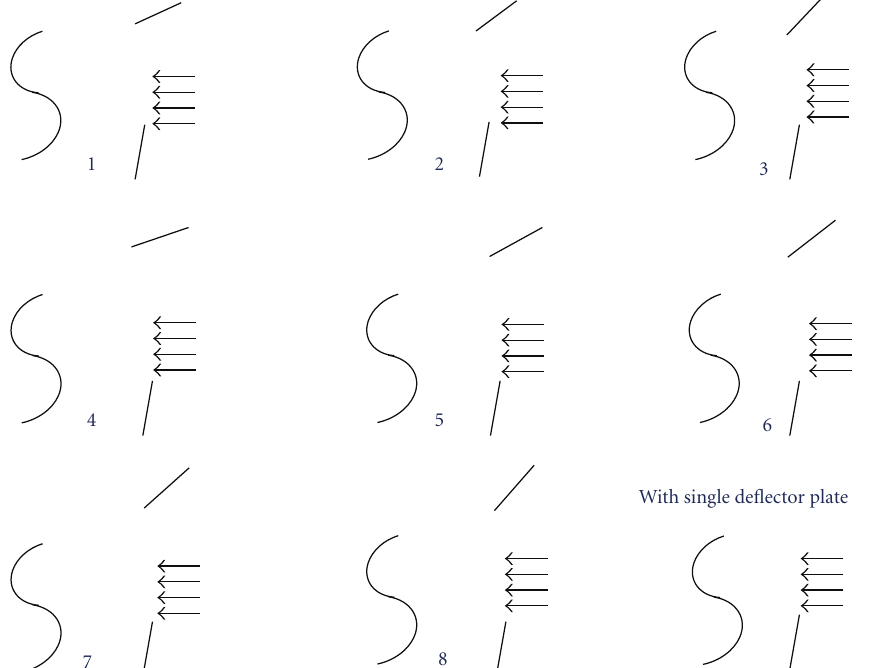
Figure 9: Di ff erent arrangements of the two deflector plates studied in the present study with the deflector plate on the returning blade side is at its optimum position.